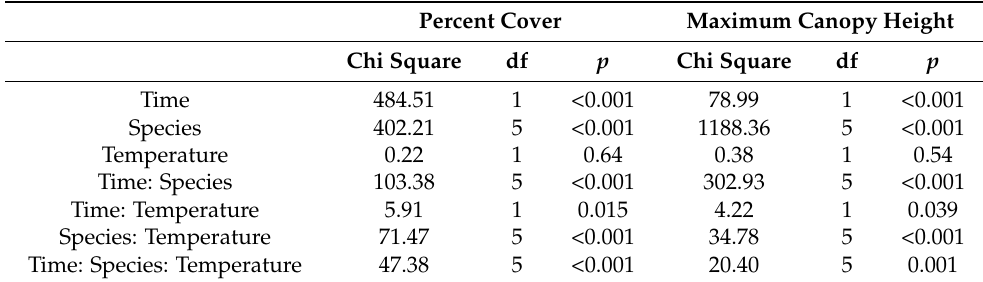
Table 2. Analysis of deviance results for percent cover and maximum canopy height for six species exposed to two temperature treatments over 20 weeks.